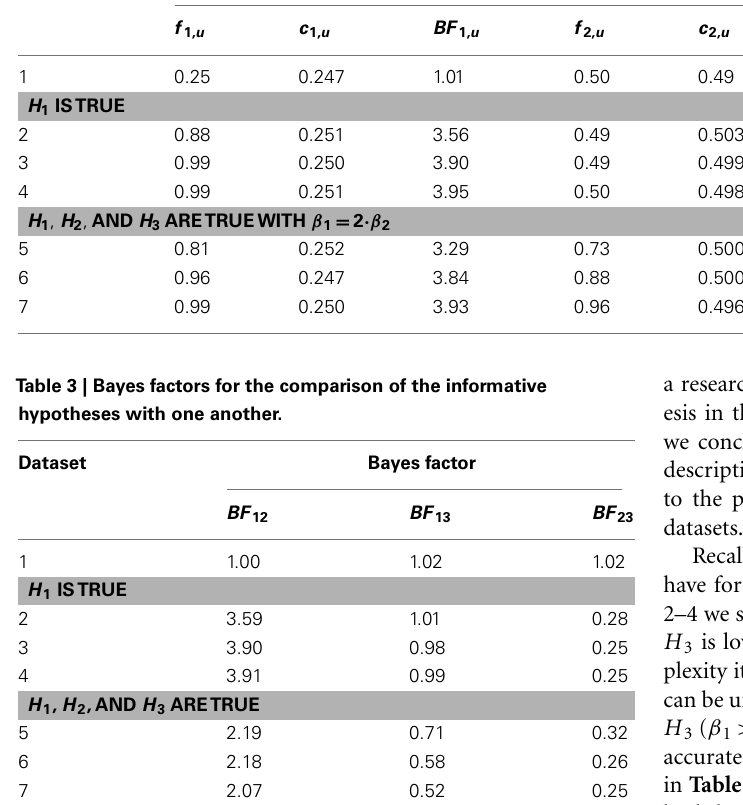
Table 2 | Results corresponding to the generated datasets: Bayes factors for each informative hypothesis against its unconstrained alternative. Dataset